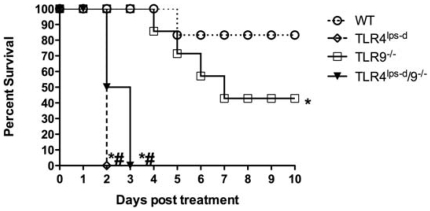
Survival after i.t. Klebsiella challenge in WT, TLR4lps-d, TLR9−/−, and TLR4lps-d/TLR9−/− mice.n = 12 in each group. *p<0.01 as compared to WT mice. #p<0.01 as compared to TLR9−/− mice. Combined from 2 separate experiments.